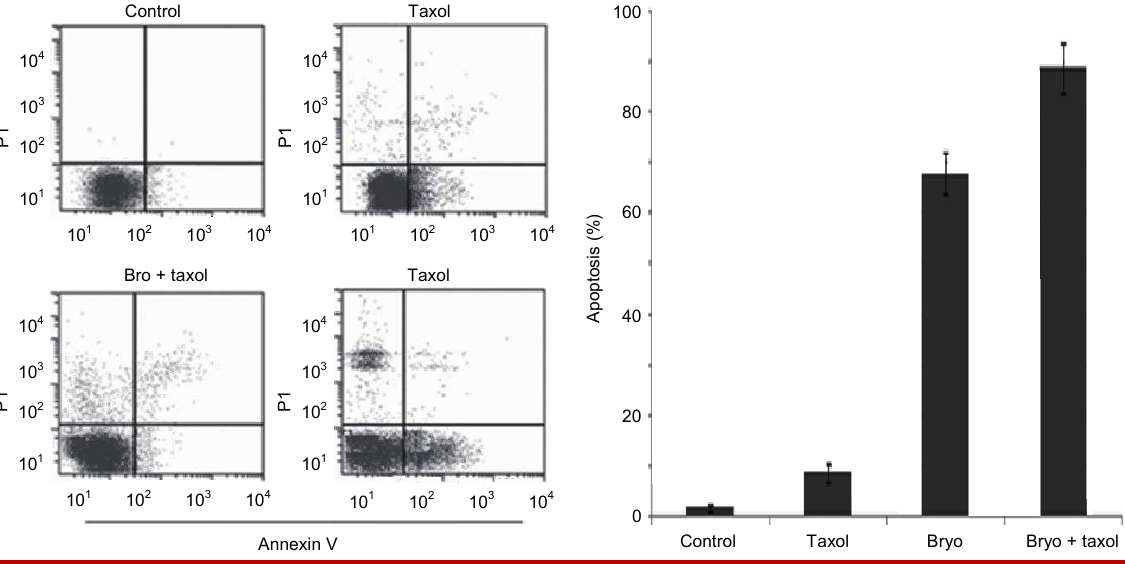
Figure 2: Bryostatin I increased the sensitivity of H3922 cells to taxol. The cells after incubation with taxol alone or pre-treatment with bryostatin I followed by incubation with taxol were analyzed of apoptosis